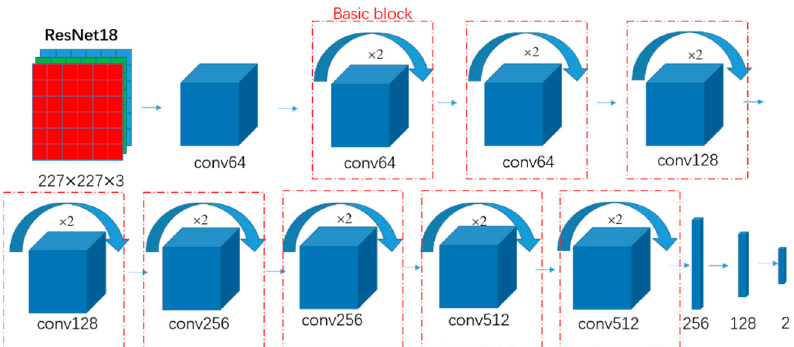
Figure 5. ResNet18